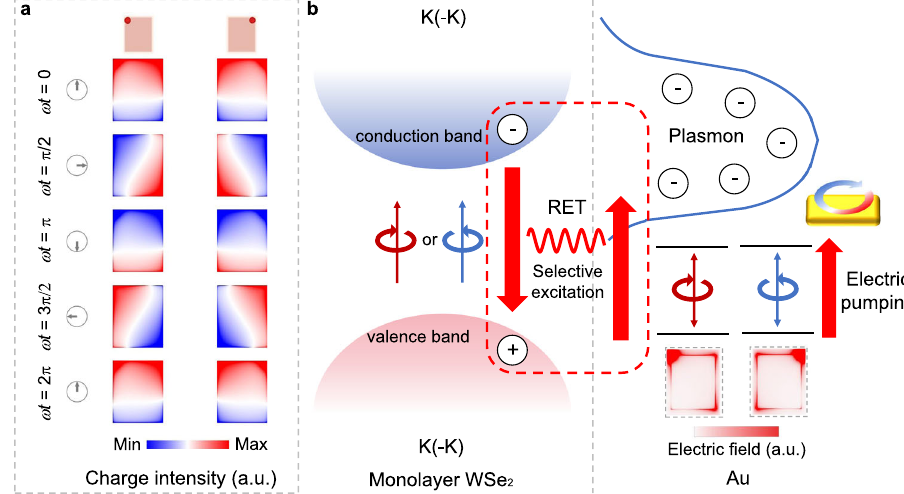
Fig. 4 Schematic of the near- fi eld control of valley polarization. a Charge distributions of Au rectangle nanoantenna excited by electron-beam impinging at top left and top right corners of rectangle. With helicity-reversed CP dipole transitions, surface charge distributions show counterclockwise and clockwise rotation over time respectively. b Schematic of near- fi eld selective excitation process via resonant energy The FDTD-simulated charge distributions of top right corner to form an in-plane circular dipole mode under electron-beam and top left corner excitation are displayed in Fig. 4a. With impinging at hotspots reciprocally. And the mirror symmetry of symmetric excitation position, the corresponding surface charge LDOS distributions and excitation positions demonstrates that evolution with time intuitively express the characterization of CP the move of electron beam from top right corner to top left corner dipole, showing a counterclockwise (clockwise) rotation of the allows the switch of LCP dipole mode to RCP dipole mode and dipole moment. However, the middle left and the top middle vice versa.